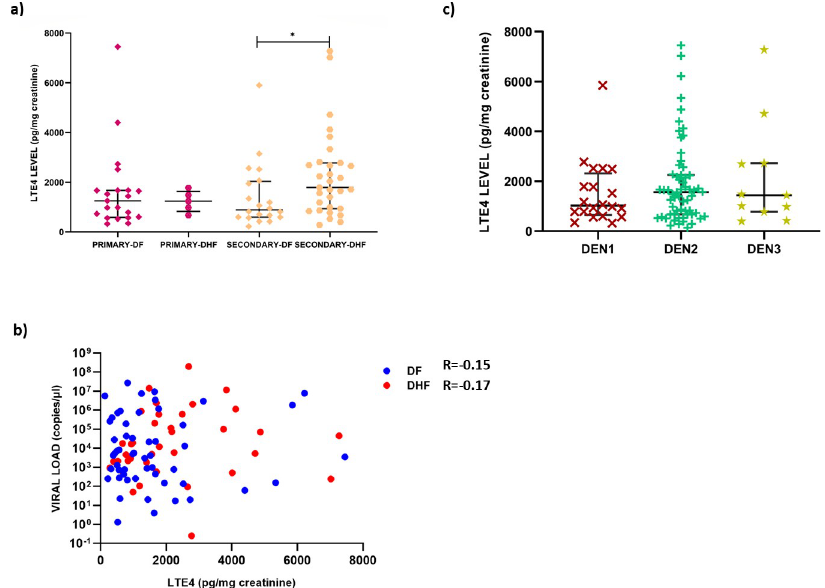
Fig 2. Association of urinary LTE4 levels with serostatus, viral loads and infecting virus serotype in patients with acute dengue. Urinary LTE4 levels were measured in patients with DF (n = 21) or DHF (n = 05) due to primary infection or DF (n = 20) or DHF (n = 22) due to secondary infection (a), urinary LTE4 levels were correlated with viral loads in patients with DF and DHF. (b), and the differences in the urinary LTE4 levels were assessed in patients infected with different virus serotypes DENV1 (n = 20), DENV2 (n = 61) and DENV3 (n = 11). The p values were calculated by the Mann-Whitney test and the correlation assessed by the Spearmans correlation. Error bars represent the median and IQR. � P <